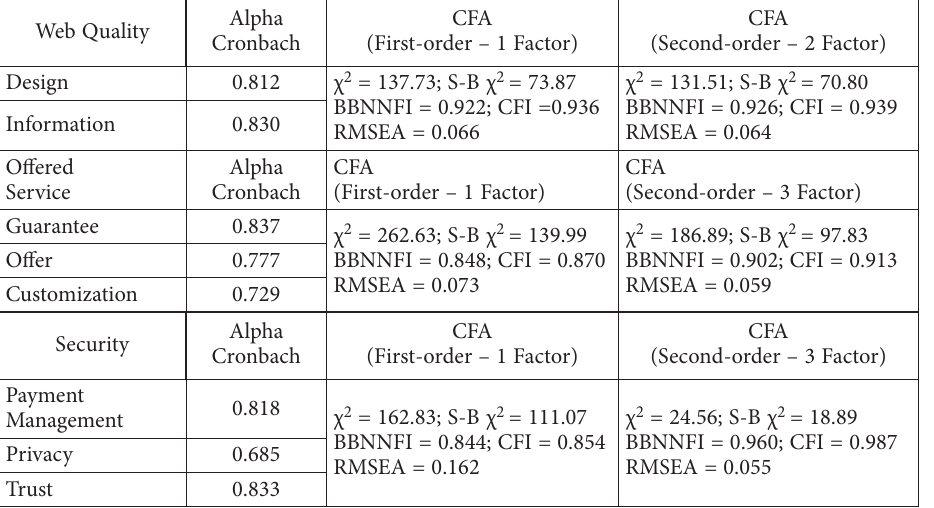
Table 3. Properties psychometric of utilitarian